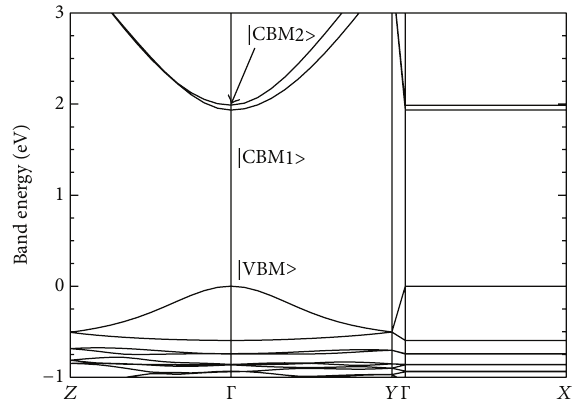
Figure 4: Electronic band structure of monoclinic crystal structure of (C 18 H 37 NH 3 ) 2 PbI 4 calculated by DFT without SOC. The energy levels are referenced to the valence band maximum.